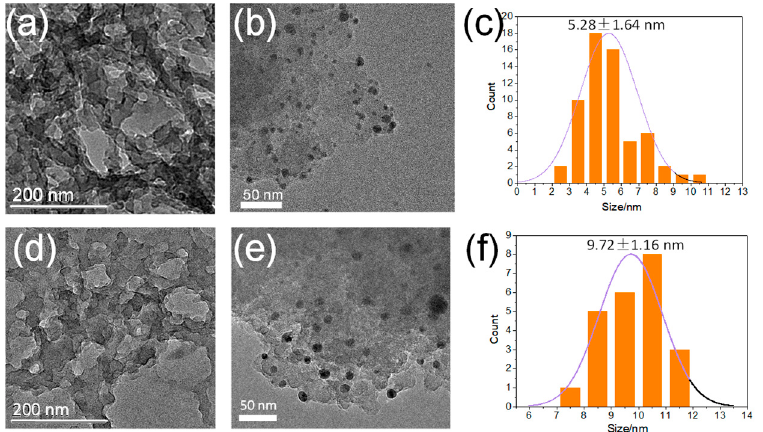
Figure 4. TEM images of: ( a ) NPOP-1, ( b ) Ag@NPOP-1, ( d ) NPOP-2, and ( e ) Ag@NPOP-2. Ag nanoparticle size distribution of: ( c ) Ag@NPOP-1, and ( f ) Ag@NPOP-2.